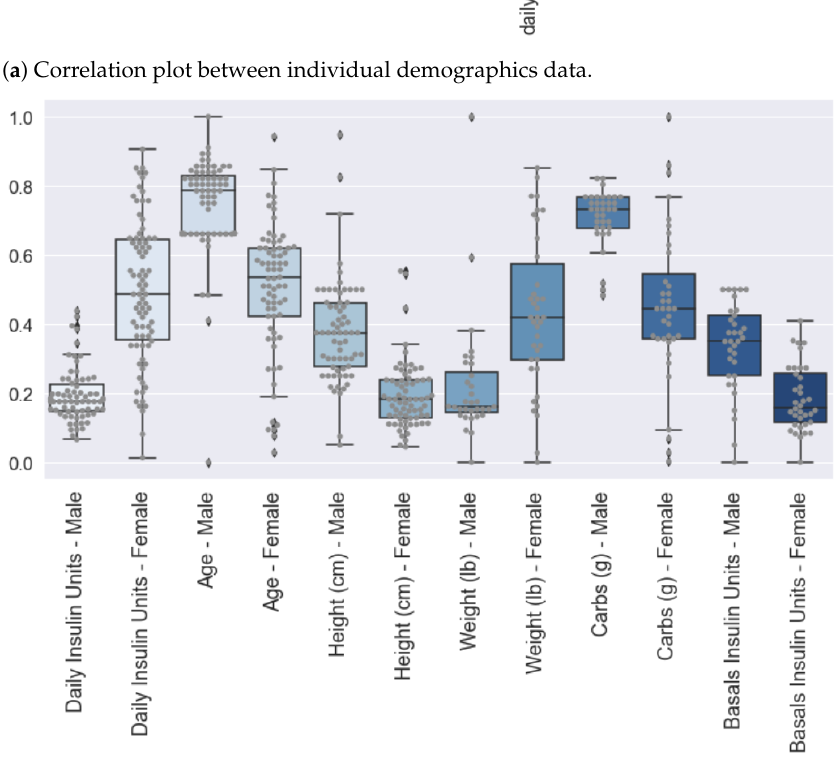
( b ) Box plot showing demographics data distribution based on genders. Antennas represent 1.5 IQR. Figure 2. Analysis of Self-reported Demographic Attributes of Insulin-Requiring Individuals using AID Technologies. Overall data (male and female combined) are normalised using MinMaxScaler function provided by Python scikit-learn library. ( a ) Shows the highest correlation of 69% between weight and daily insulin units. Second-highest correlation is between weight and basal units equal to 61%. ( b ) The distribution of self-reported demographics with respect to gender shows a greater intake of carbs and basal in males as compared to females. Average insulin intake by males and females is 45.58 and 49 units,